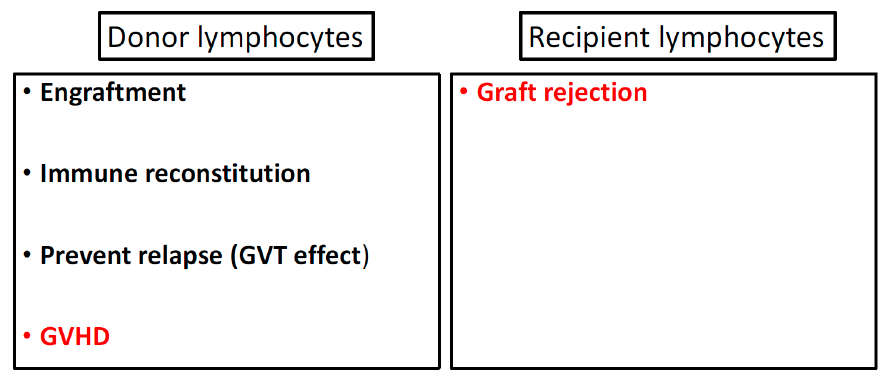
Figure 1. Immune balance between donor and recipient lymphocytes showing favorable ( black ) and unfavorable ( red ) effects played by each side. GVT = graft versus tumor.